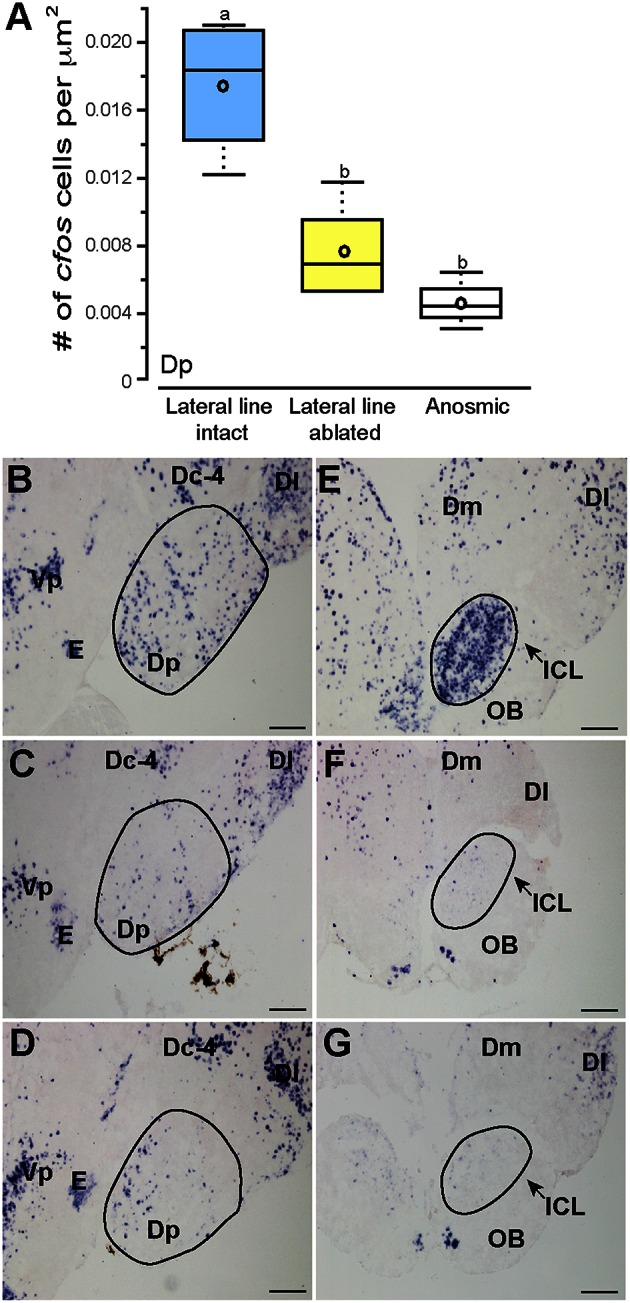
Cobalt chloride treatment impaired olfactory processing in lateral line-ablated fish. Quantification of cfos staining in the known telencephalic olfactory processing region, Dp (A) of lateral line-intact (blue; N = 6), lateral line-ablated (yellow; N = 5), and anosmic (white; N = 3) fight winners and corresponding photomicrographs of representative cfos staining in the Dp of a lateral line-intact (B) -ablated (C), and anosmic (D) animal, and the olfactory bulbs of an intact (E), ablated (F), and anosmic (G) animal. Circled regions represent the area quantified for each nucleus. Different letters indicate statistical significance at P < 0.05 using post-hoc LSD tests. Scale bars in (B–G) represent 100 μm. See Figure 1 legend for box plot descriptions. See list for abbreviations.